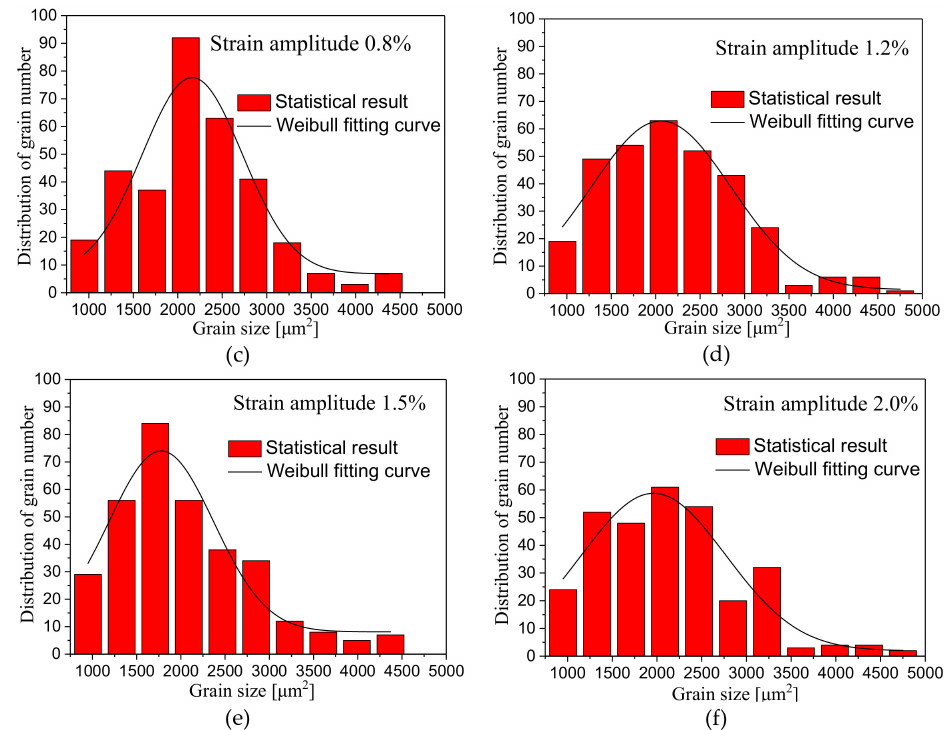
Figure 5. Distribution diagram of grain area size corresponding to di ff erent strain amplitudes: ( a ) 0.3%; ( b )0.5%; ( c ) 0.8%; ( d ) 1.2%; ( e ) 1.5%; ( f ) 2.0%.